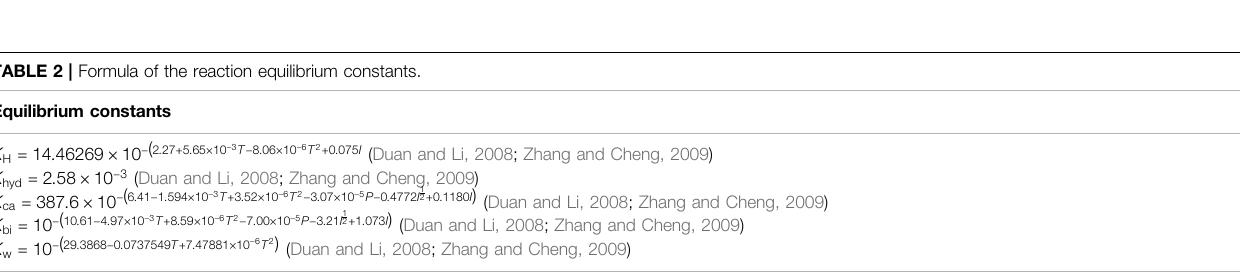
TABLE 2 | Formula of the reaction equilibrium